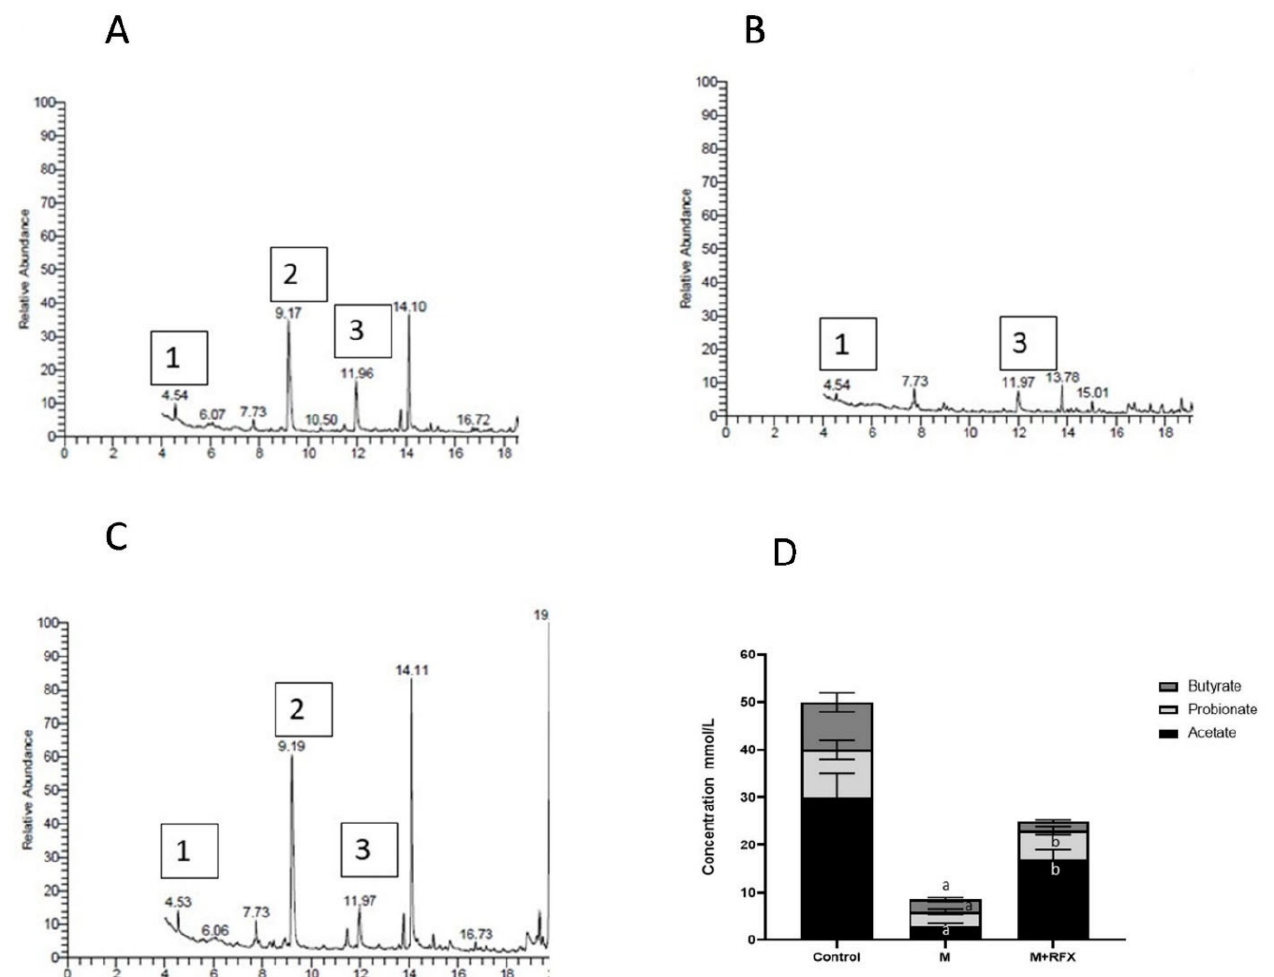
Figure 9. Modulation of short chain fatty acids in serum after RFX intervention in rats exposed to malathion for four weeks. Gas chromatogram showing acetic acid (1), propionic acid (2) and butyric acid (3) in the control group ( A ), malathion group ( B ) and malathion+rifaximin group ( C ). ( D ): Representative stacked column for the concentration of SCFAs in serum (mmol/L) as calculated according to the corresponding peak area of acid in gas chromatogram. Data are presented as the means ± SEM. a, significant ( p < 0.05) versus control; b, significant ( p < 0.05) versus the malathion group; data were analyzed with one-way ANOVA followed by Bonferroni-corrected post hoc tests. RFX, rifaximin; M, malathion; M + RFX, malathion and rifaximin.